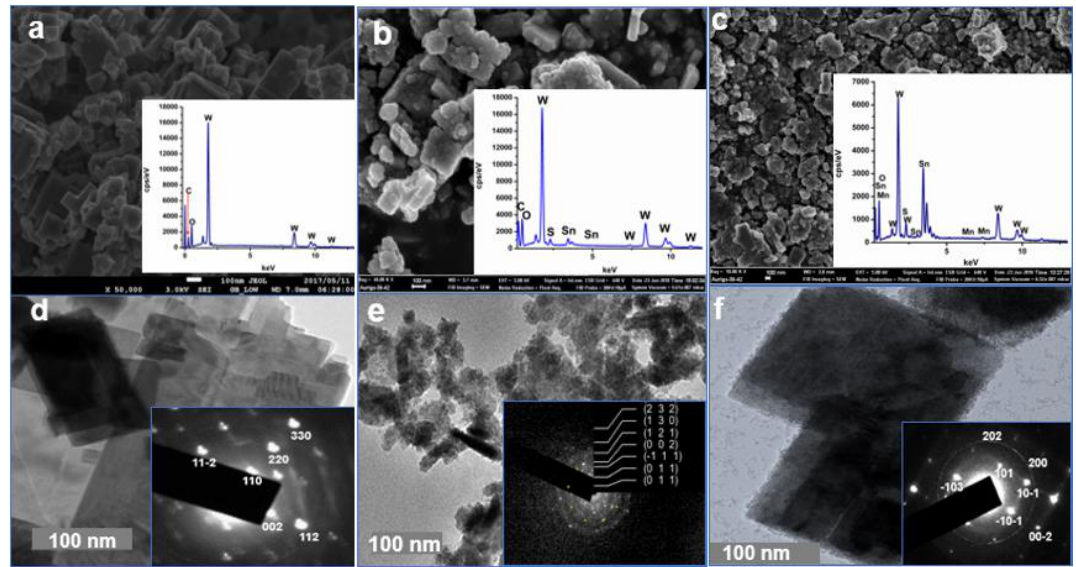
Figure 3. FESEM images (inset is the corresponding energy-dispersive X-ray (EDX) spectrum) of ( a ) pristine WO 3 , ( b ) WO 3 /SnS 2 and ( c ) Mn-WO 3 /SnS 2 , and TEM images (inset is the corresponding selected area electron diffraction (SAED) image) of ( d ) WO 3 , ( e ) WO 3 /SnS 2 and ( f ) Mn-WO 3 /SnS 2 .